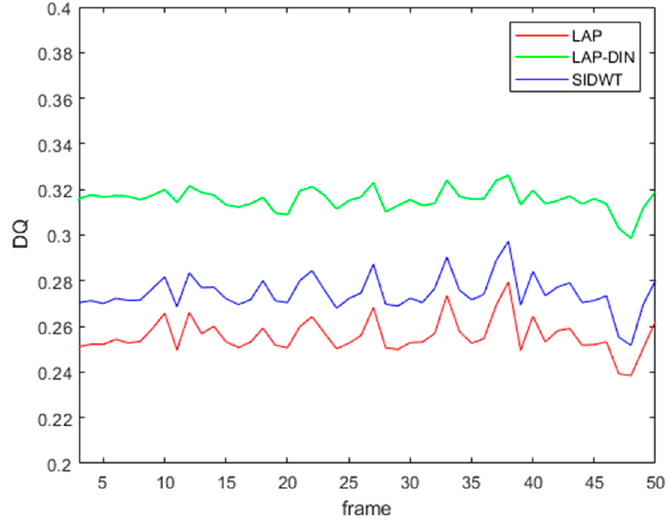
Figure 14. Temporal fusion performance stability.